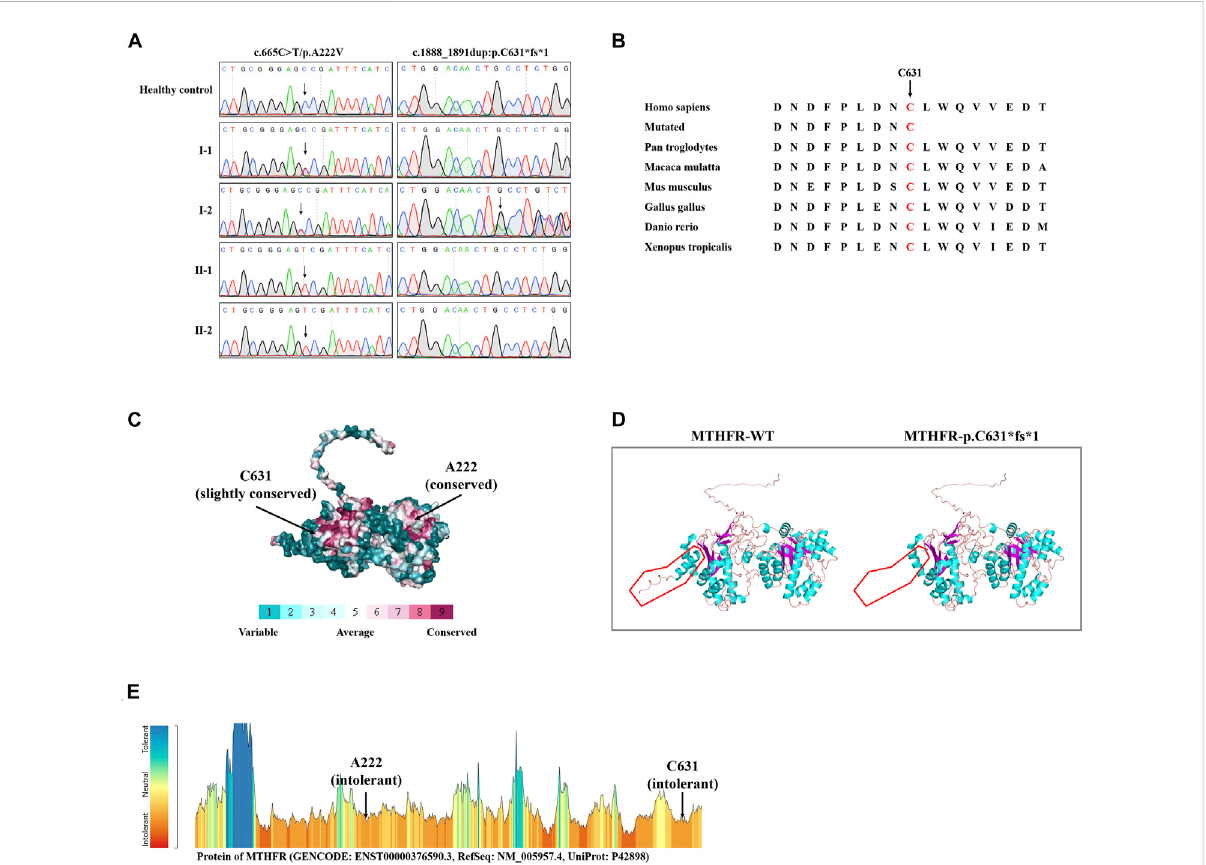
FIGURE 2 Sequencingdataandbioinformaticsanalysisof MTHFR variants. (A) Sangersequencingresultsofthe MTHFR variantsinthisfamily. (B) Alignment of multiple MTHFR protein sequences across species. Letters in red show the C631 sites that are evolutionarily conserved. (C) Conservation analysis of the D612 amino acid was predicted by ConSurf Server software. (D) Structural prediction of the mutant protein. The wild-type MTHFR ( MTHFR - WT) protein structure and the p. C631*fs*1 mutant MTHFR ( MTHFR -p.C631*fs*1) protein structure were predicted by SWISS-MODEL online software. (E) MetaDomeserverwasusedtoidentifytheintolerantregionsin MTHFR .Asdepicted,theaffectednucleotides/residuesarelocatedinthe intolerant